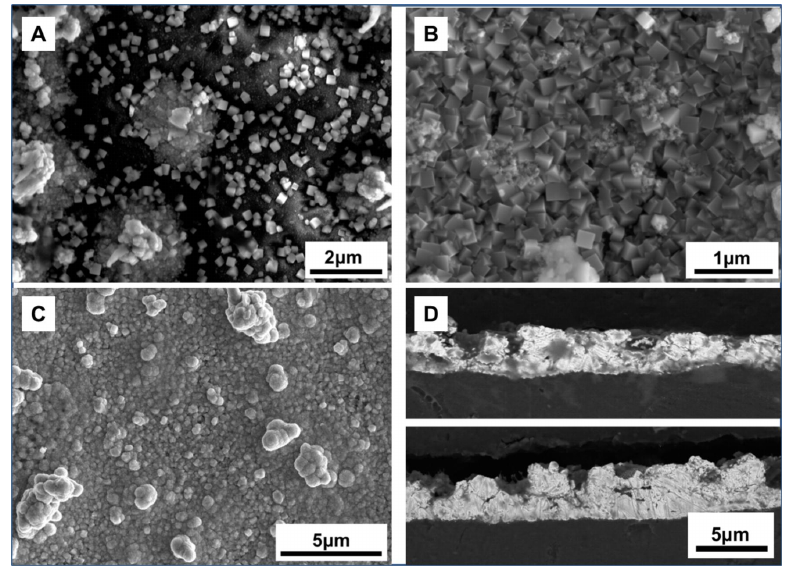
ff erent growing stages. Times after immersion were Figure 7: Figure 6. ( A – C ) SEM micrographs showing the di of 90, 180 and 300 s respectively. The cubic structures of the incipient copper crystals are visible in ( A , B ). ( D ) is the cross section of the S3 sample (60 min) coatings at two di ff erent locations. SEM pictures were taken with the hybrid backscattered / secondary electron mode of